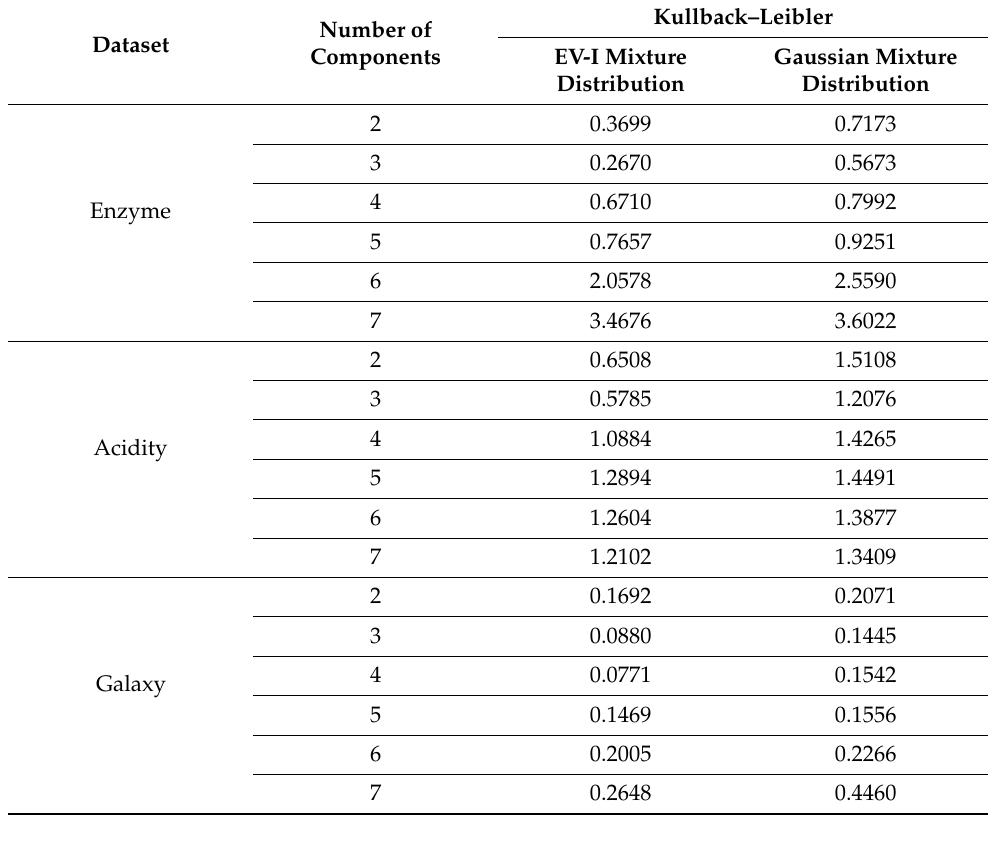
Table 7. Comparison of Kullback–Leibler divergence using EV-I mixture and Gaussian mixture distributions for enzyme, acidity, and galaxy datasets.